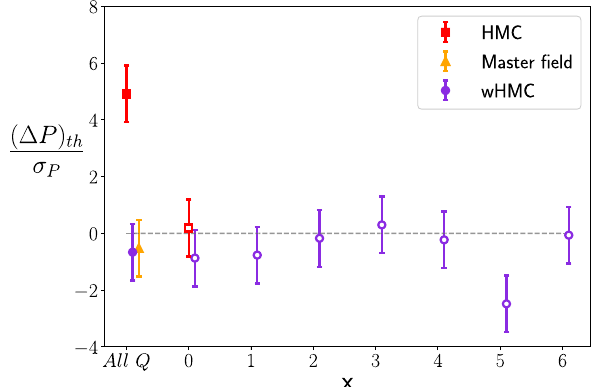
Fig. 10 Scaling of the autocorrelation time for Q 2 times the cost ratio, Eq. (30), with β for HMC and wHMC. The pion mass is kept approxi- √ β ∼ 0 . 65 mately constant, M π